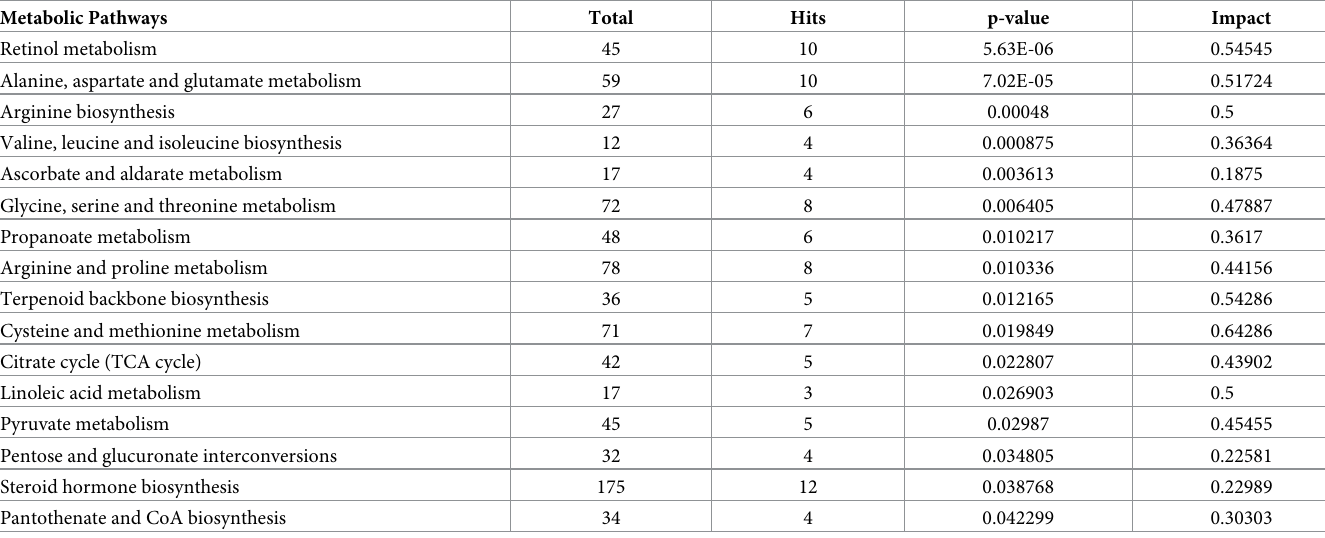
Table 1. Significantly perturbed metabolic pathways identified by integrated proteomics and metabolomics